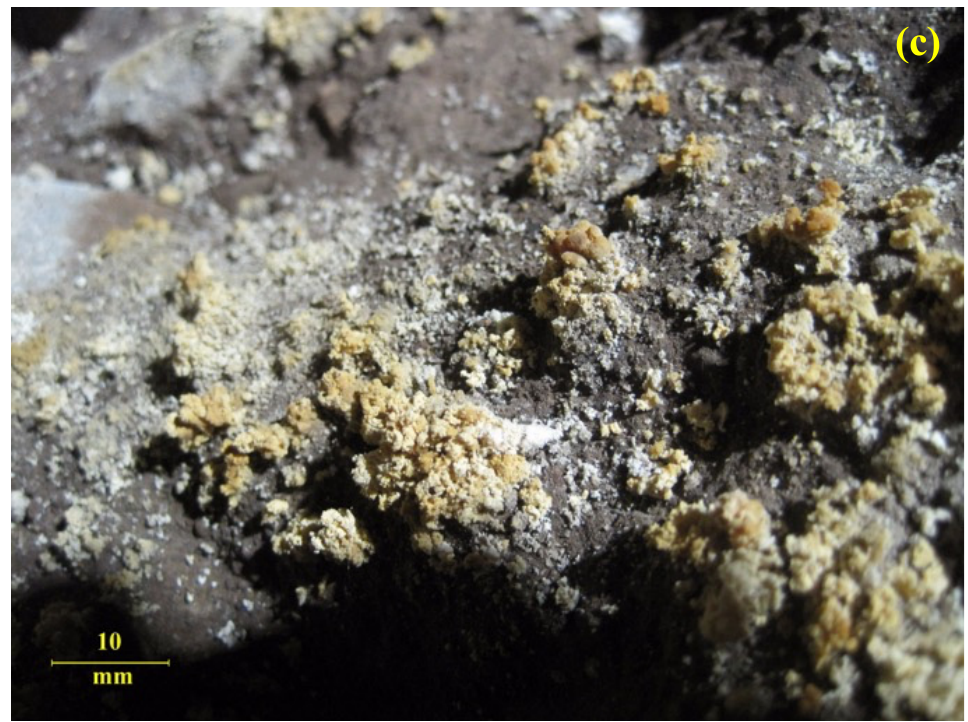
Figure 2. Photos of the degradation ( a ) of the floor and ( b ) of the wall and optical microscope image ( c ) on the surface of the black and white mosaic pavement (10× and 40× magnification, respectively; width focusing 25 mm, 2 mm increments; 6 V/20 W halogen light). The sample of the degradation product of the black and white pavement mosaic of domus B was analyzed under an optical microscope in transmittance and reflectance).